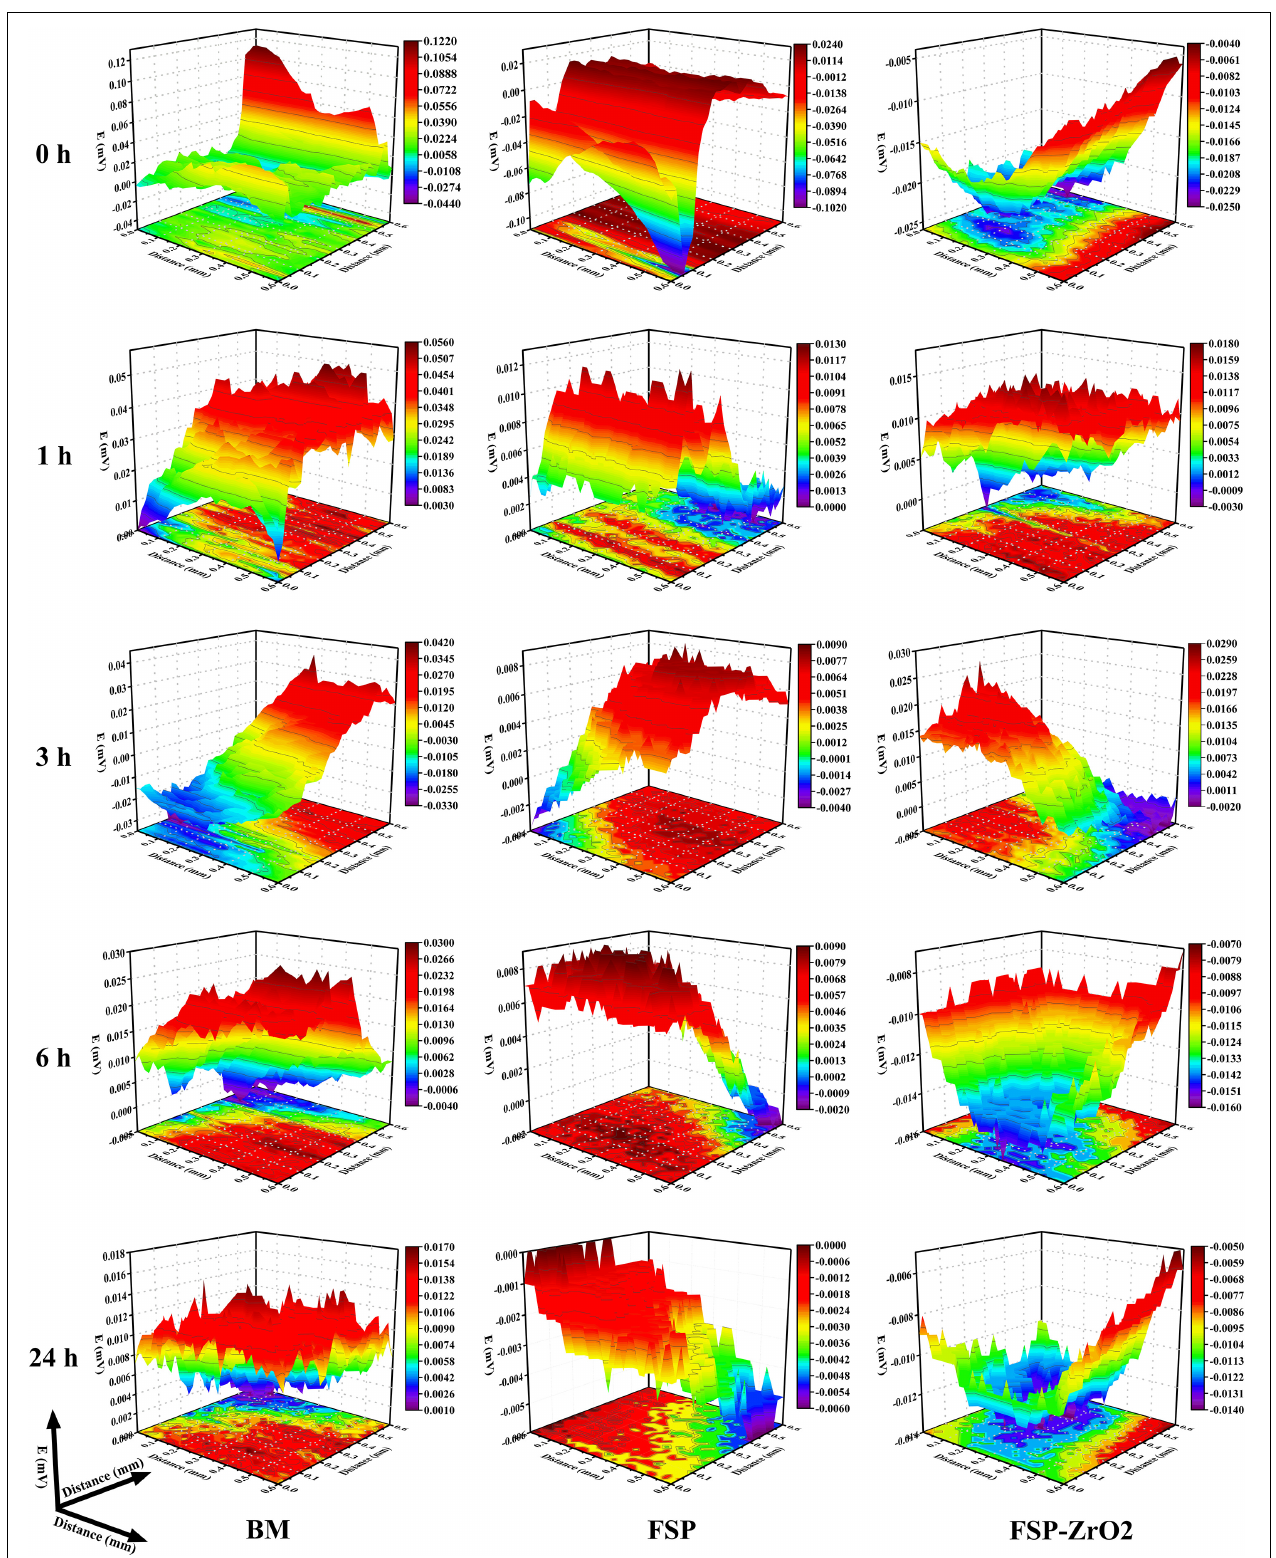
FIGURE 12 | The SVET voltage maps of BM, FSP and FSP-ZrO 2 samples in SBF solution for 0 h, 1 h, 3 h, 6 h, 24 h, respectively.